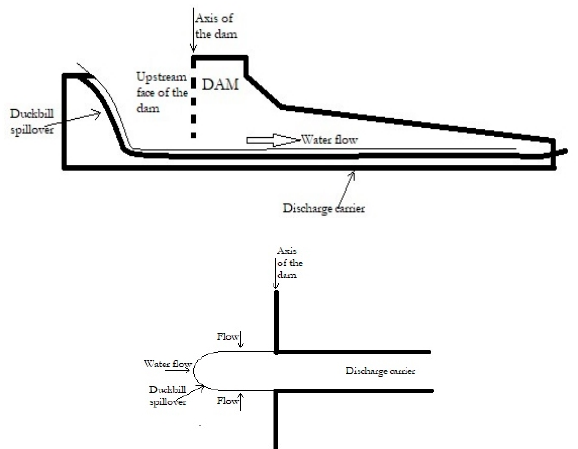
Figure 2. Cross section ( above ) and upper view ( below ) of the duckbill spillover. Elaboration: